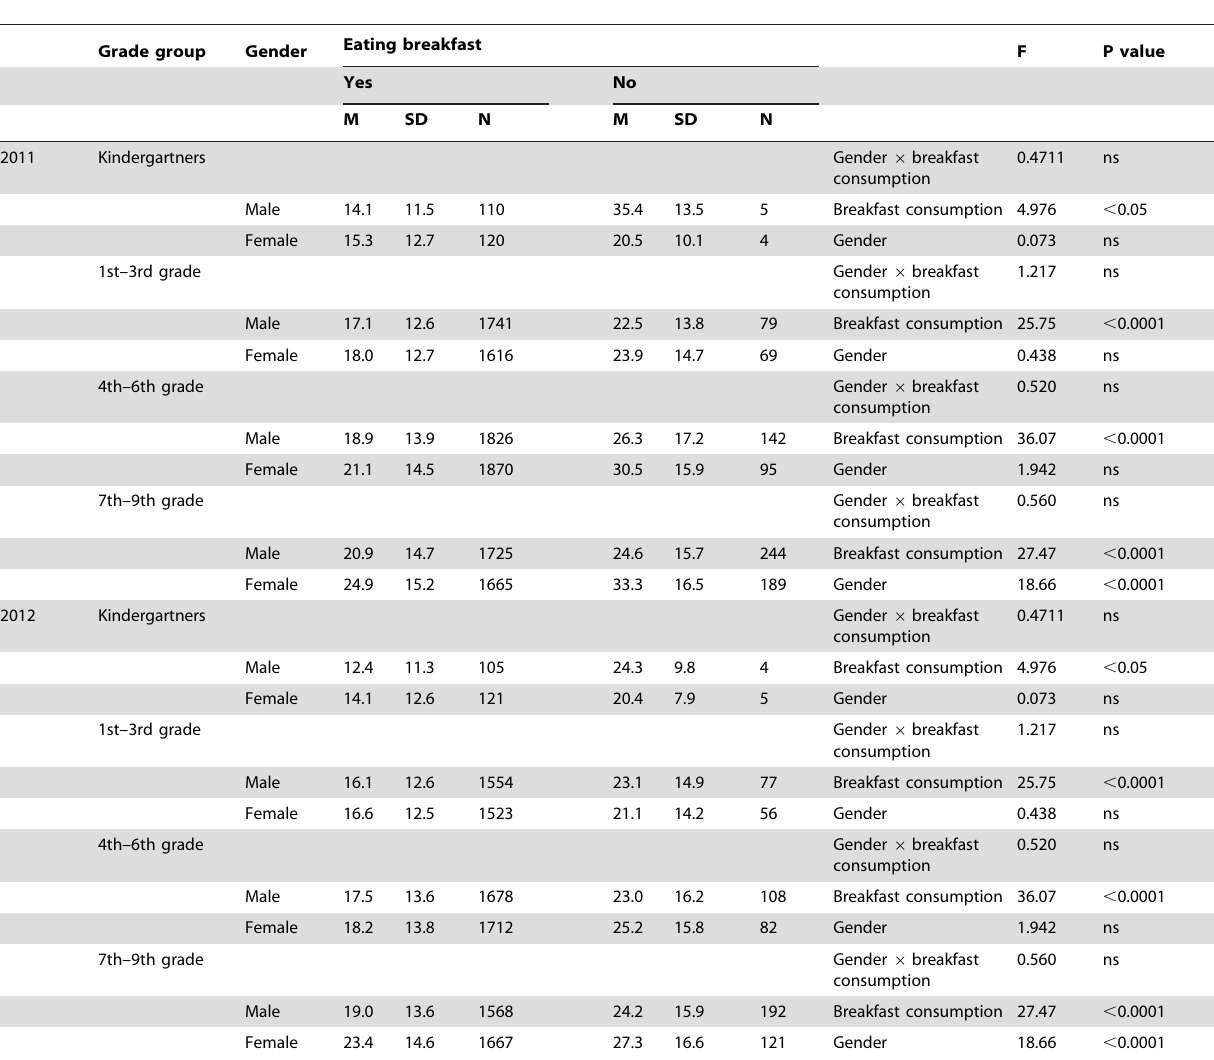
Table 6. Average PTSSC-15 score (grade, gender, and breakfast consumption) in 2011 and 2012.